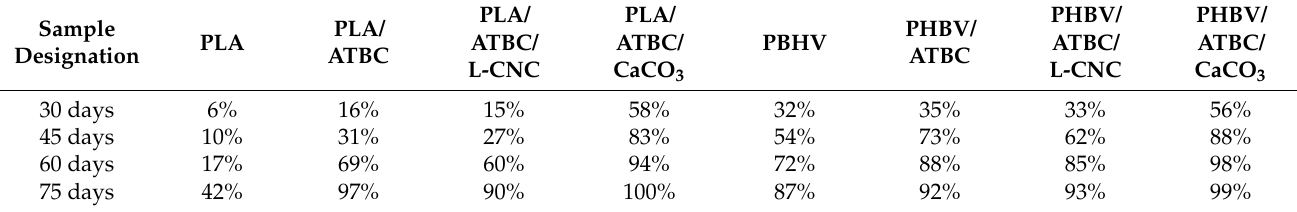
Table 3. Comparison of biodegradation level of PHBV and PLA bio-composites